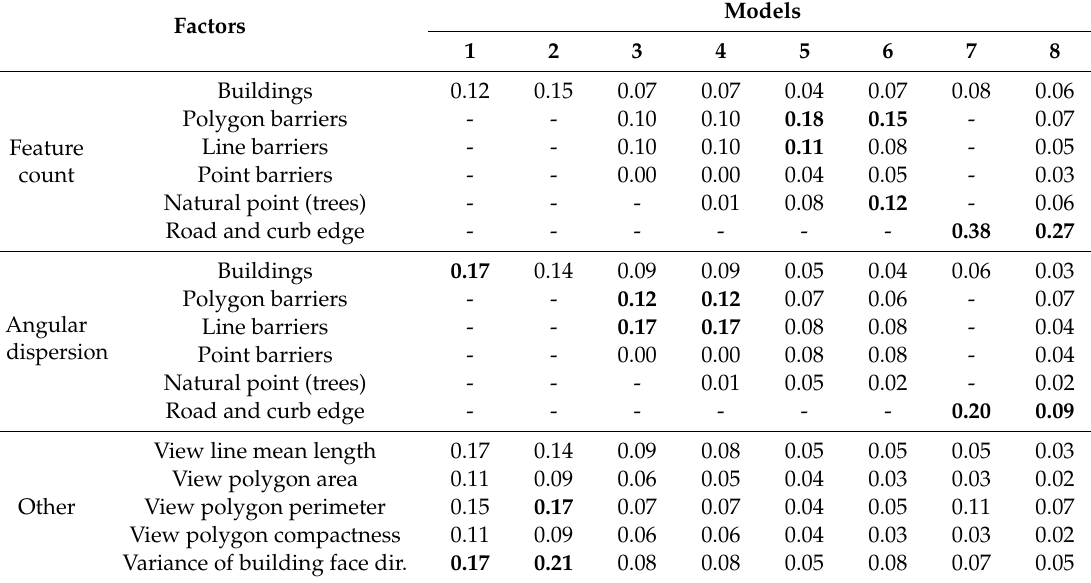
Table 5. Factor importance of the eight predictive models. The two most important factors in each model are emphasized in bold.